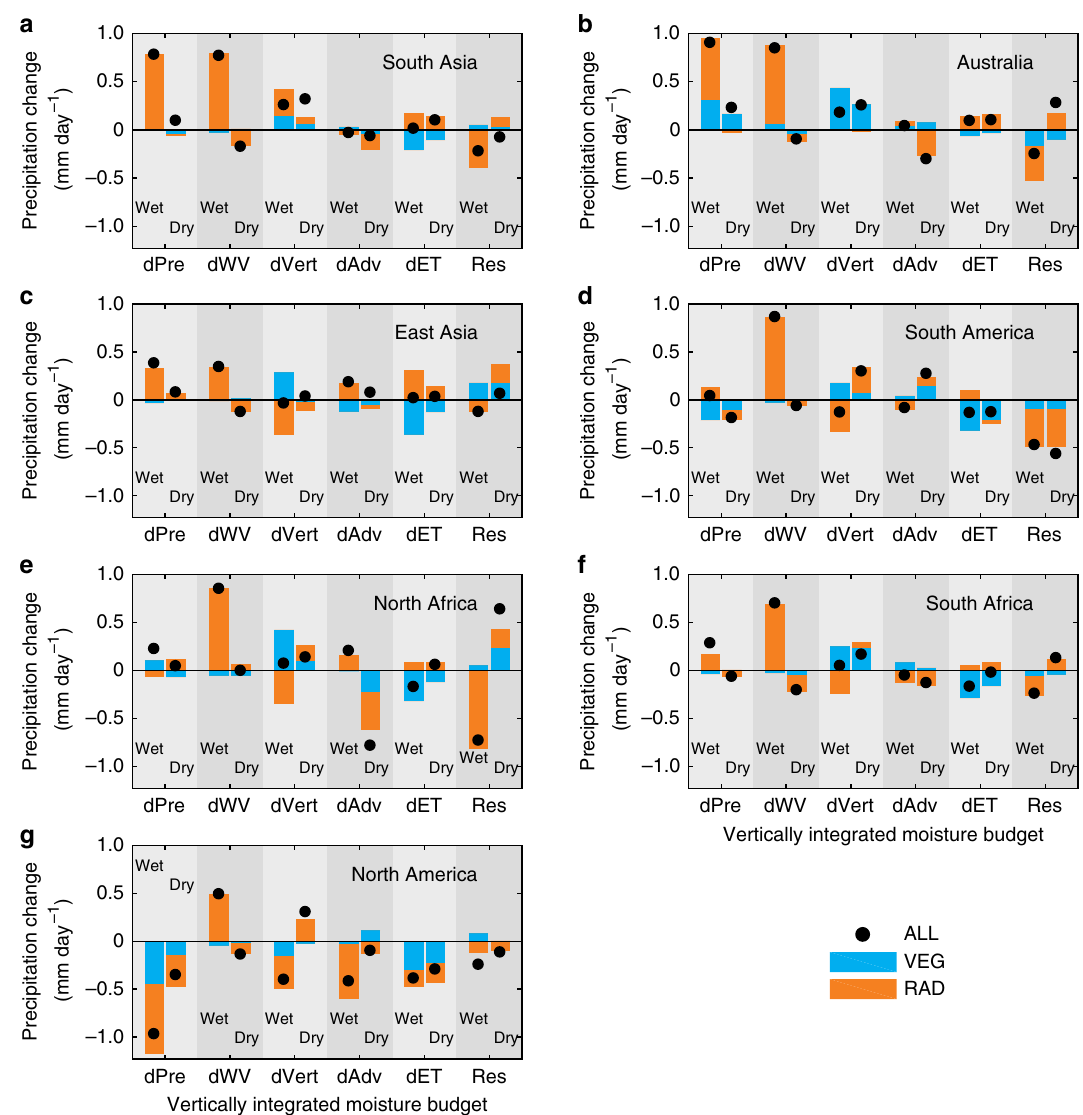
Fig. 3 Regional components of precipitation change associated with different processes in both wet and dry seasons. Each panel a – g corresponds to one of seven monsoon regions, as marked. Monsoon regions on the left-hand and right-hand sides are located in Northern Hemisphere and Southern Hemisphere, respectively. In each panel, different contributions to rainfall changes are presented. The fi rst column pair are the total precipitation change (dPre). The next four column pairs are: thermodynamic effect, i.e., atmospheric water vapour changes (dWV), vertical dynamic effect changes (dVert), altered horizontal advection (dAdv) and land evapotranspiration change (dET), respectively (see Methods section). The Residual effect (Res) is the difference between total precipitation change (dPre) and the sum of the four processes (dWV + dVert + dAdv + dET). For dPre, the four individual drivers and Res, there is a further subdivision, with the left and right columns showing changes in the wet and dry seasons respectively. Each process is further divided into radiative (RAD, orange bars) and physiological (VEG, blue bars) drivers in wet and dry seasons, while the black circles are from the ALL